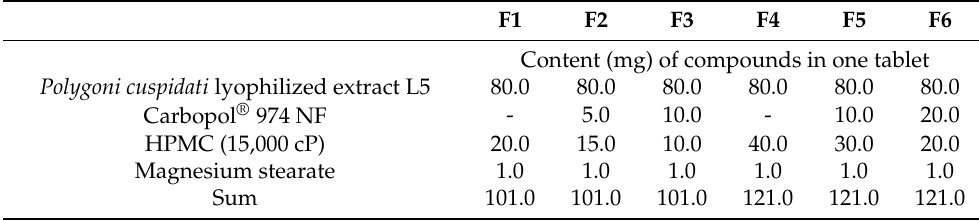
Table 2. Chemical composition of extracts and lyophilized